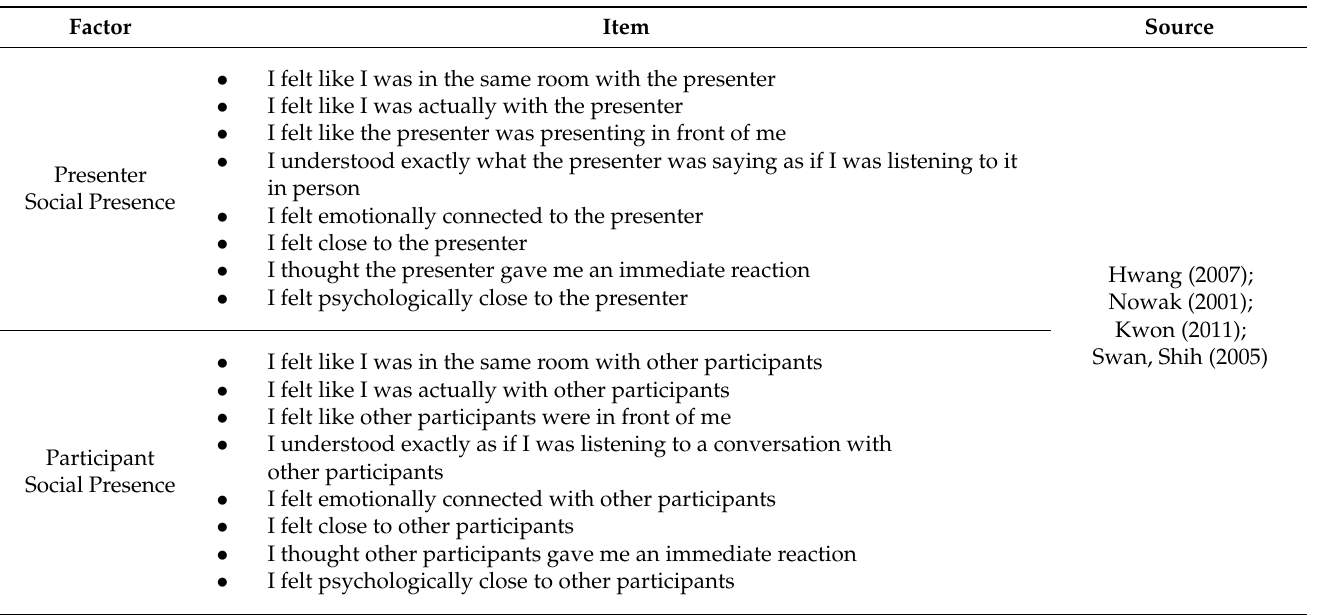
Table 2. Video conference social presence.